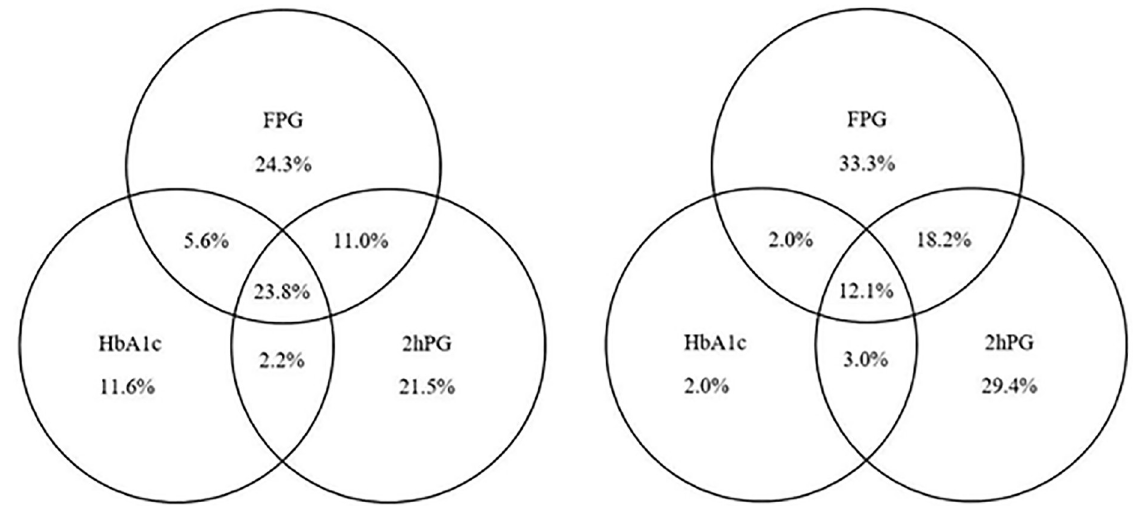
Fig 1. Diagnosis of diabetes. The percentage of participants diagnosed with diabetes in the first wave (n = 181 out of 2309) and the second wave (n = 108 out of 2612) . Diabetes mellitus was diagnosed when at least one of the following criteria were met: FPG � 7.0 mmol/l; 2hPG � 11.1 mmol/l; HbA 1c � 48 mmol/mol